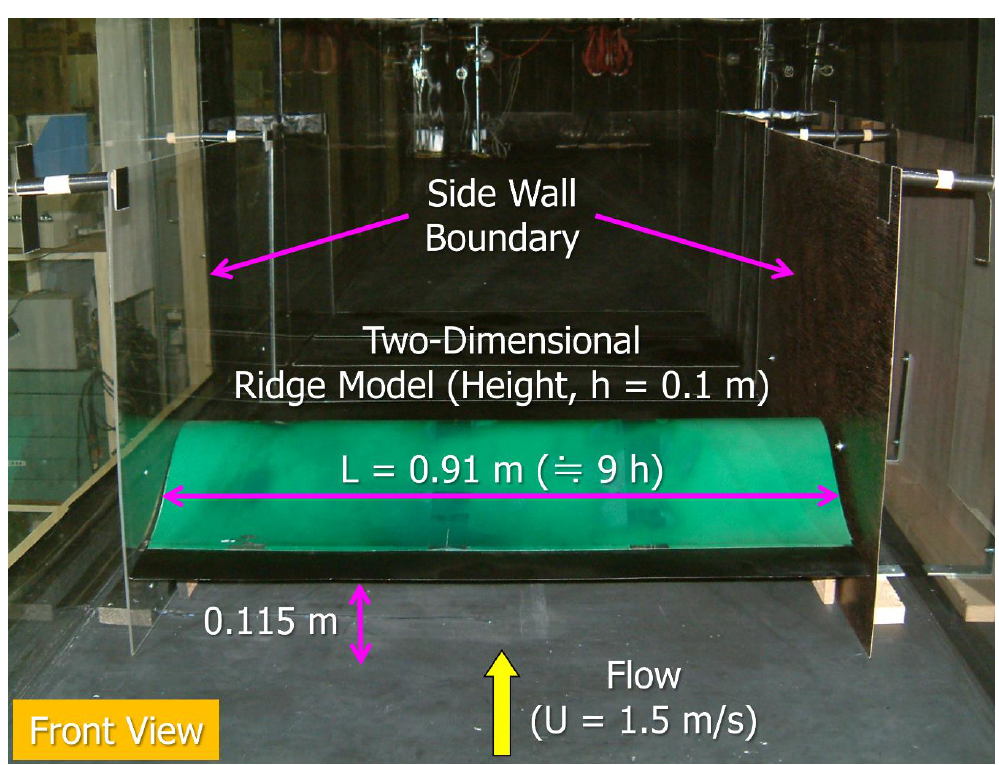
Figure 3. Two-dimensional ridge model installed in the wind tunnel.